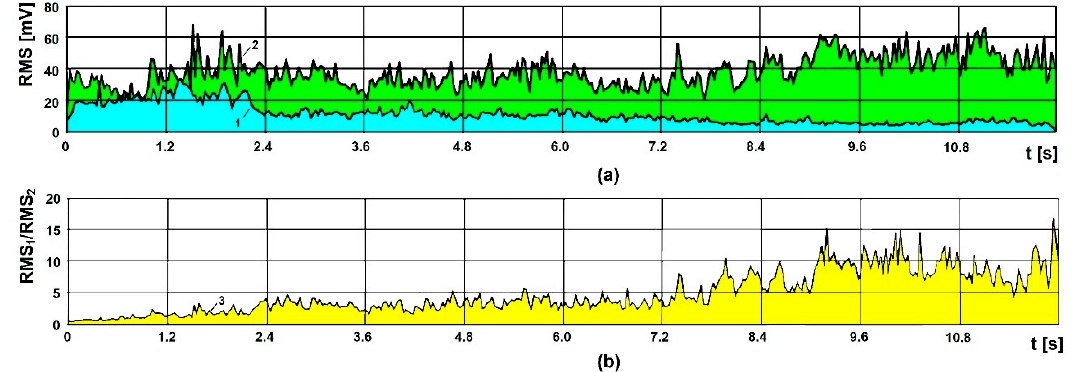
Figure 9. RMS of vibroacoustic signals during 12 s of electrical discharge machining of M05 hard alloy: ( a ) RMS of vibroacoustic signal; ( b ) proportional ratio of RMS1/RMS2, where (1) is an octave band of 2 kHz; (2) is an octave band of 32 kHz; (3) is the result of interconnection.